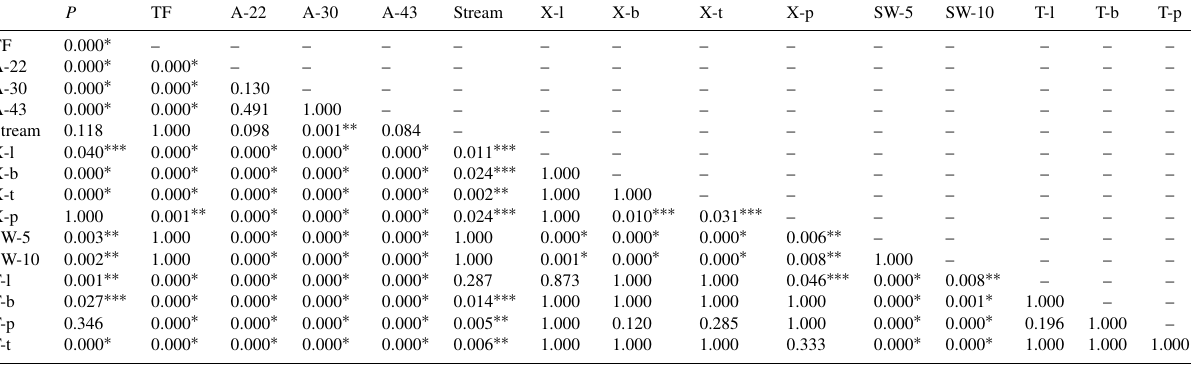
Table J1. Pairwise comparisons to determine differences in lc-excess values among the different sample types. The asterisks describe the significance level of the comparison at p = 0 . 05 ( ∗∗∗ ), p = 0 . 01 ( ∗∗ ), p = 0 . 001 ( ∗ ) and no differences